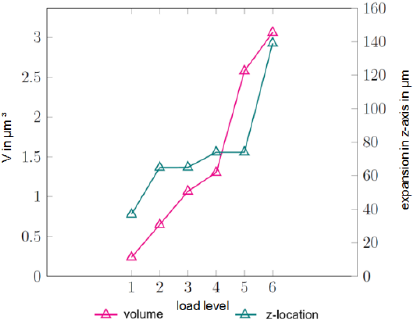
Figure 13 . Geometrical change of a defect during in situ tensile testing of a BASCA heat-treated